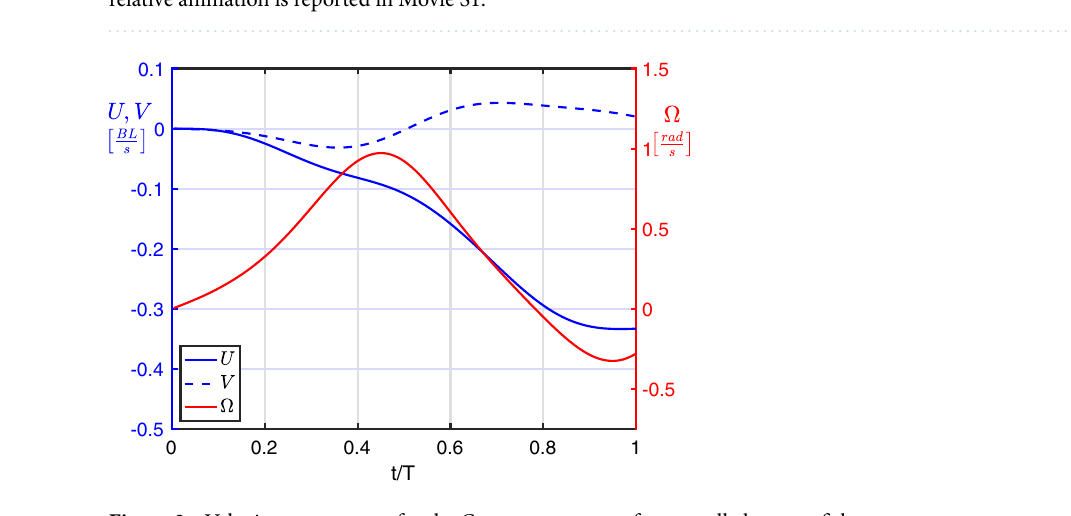
Figure 2. Velocity components for the C-start maneuver of a neutrally buoyant